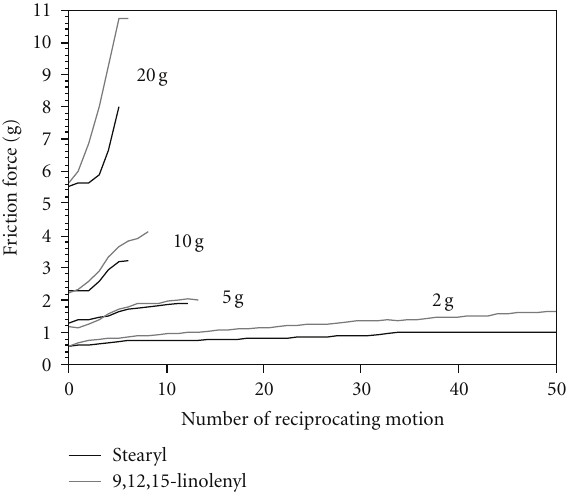
Figure 16: Change in friction force of stearic acid and linolenic acid salts in pin-on-flat